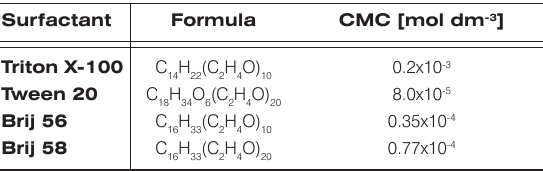
Table 1. Surfactants used in the study and their critical micelle concentration (CMC)